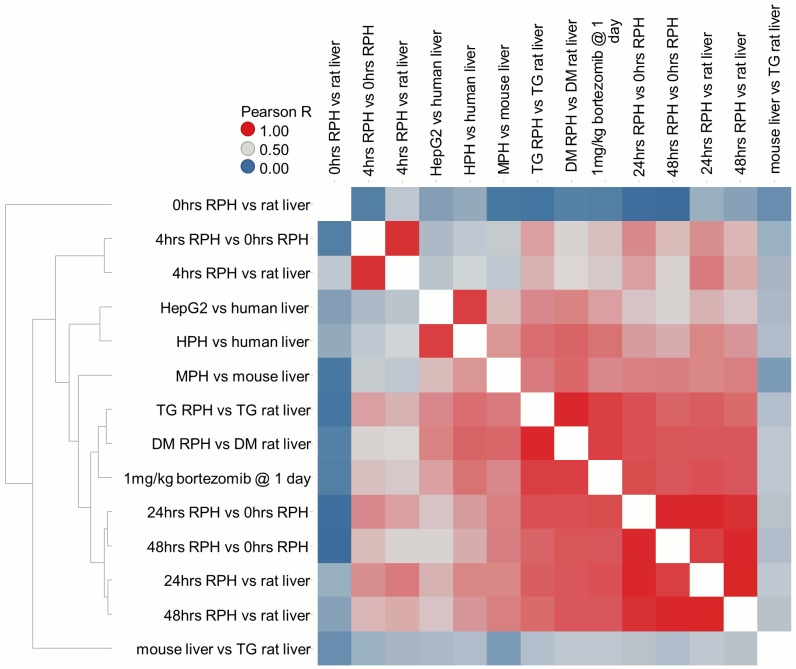
Correlation analysis of transcriptional changes in hepatocyte cell culture.Co-expression network analysis of expression changes when comparing mRNA between cultured hepatocytes vs. liver or immediately after hepatocyte isolation (vs. 0hrs RPH). Cells are colored on the Pearson correlation coefficient R obtained by comparing module scores for two conditions. Conditions are clustered to group those showing similar scores across 415 modules, revealing broad similarity following 24–48 hours in culture for RPH, HPH, MPH and HepG2 cells from various sources.